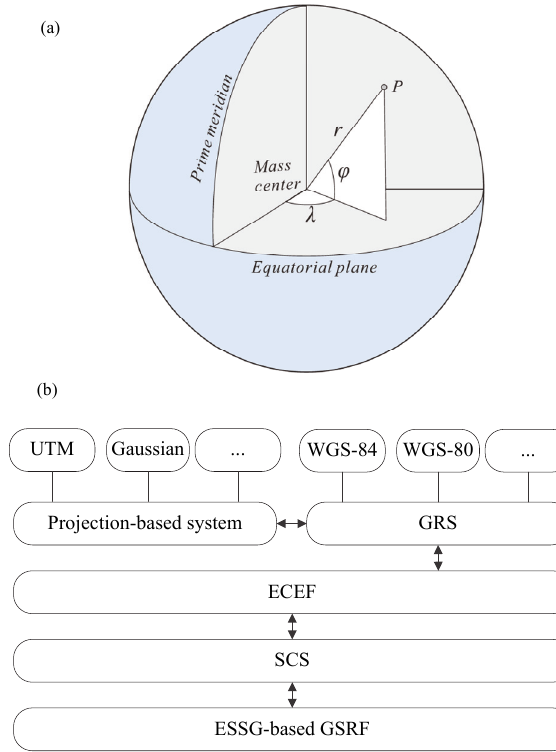
Figure 7 The definition of SCS and the transformation route between ESSG-based GSRF and other GSRFs. (a) Definition of SCS; (b) transformation route between ESSG-based GSRF and other